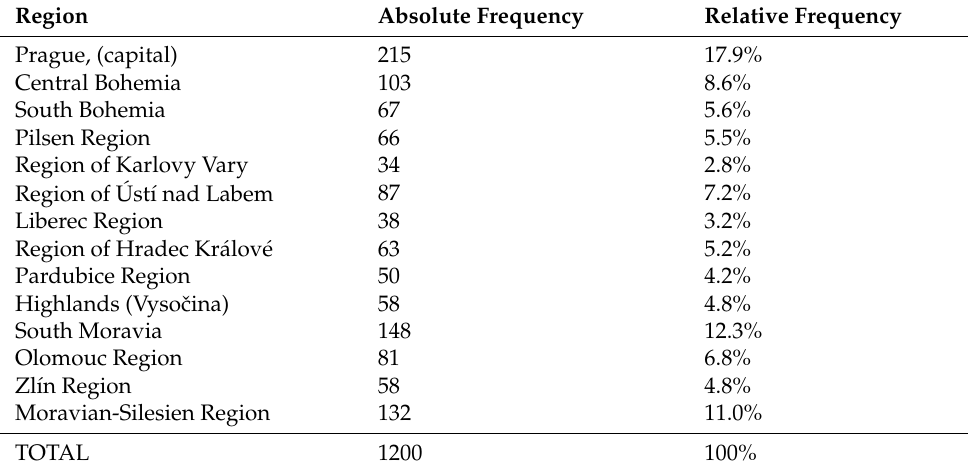
Table 1. Statistical data for each